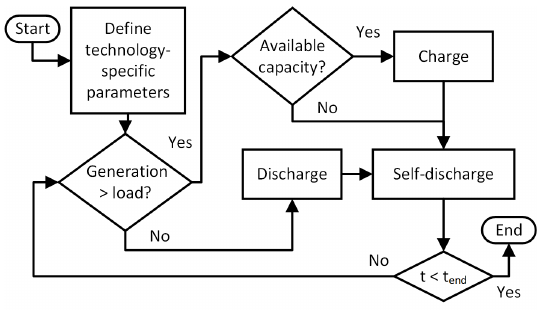
Figure 13. Proposed procedure for sizing of the energy deficit and potential solutions for a specified generation portfolio. Minute to minute variation largely defines reliability for systems with high renewable energy penetration and can be accounted for using a broad spectrum of technologies to shift energy when